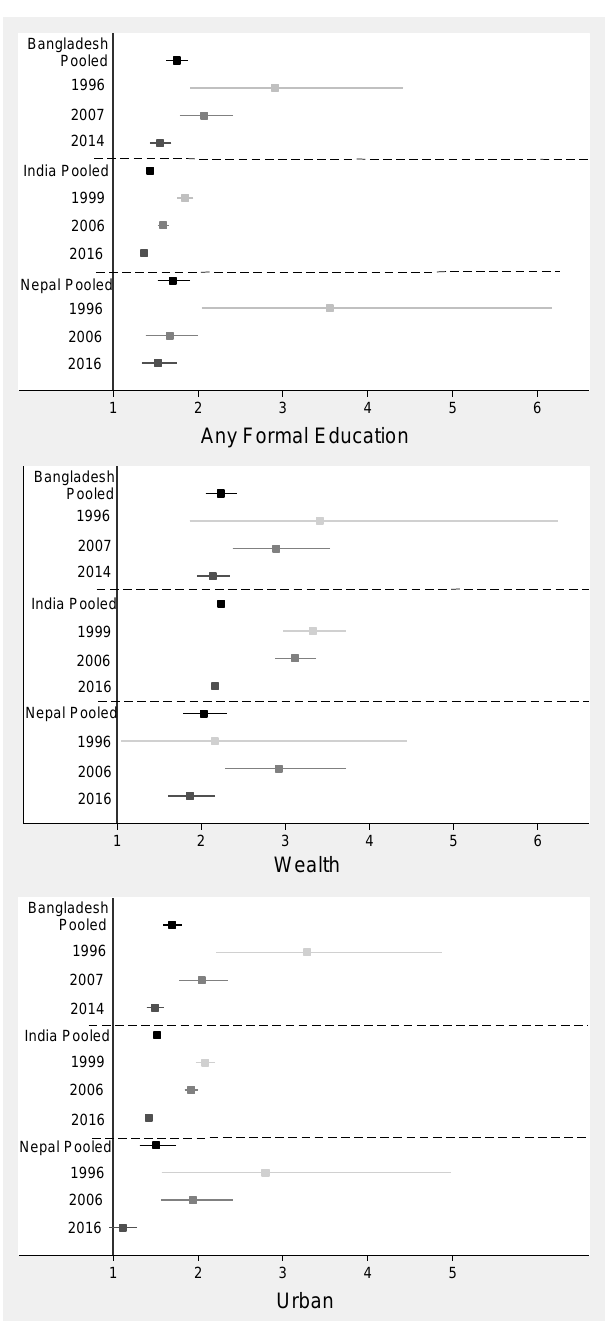
Figure 3. Adjusted Prevalence Ratios (95% CI) 2 for overweight 1 among women and three key factors in Bangladesh, India and Nepal, presented pooled (black squares) and stratified by survey year (light grey, 1990s time point; medium grey, early 2000s time point; dark grey, most recent time point in 2010s). 1 Overweight is defined as a body mass index ≥ 25.0 kg / m 2 . 2 Each adjusted prevalence ratio represents a separate modified Poisson model controlling for the other factors listed in the table, woman’s age, country -specific sub-region and cluster.